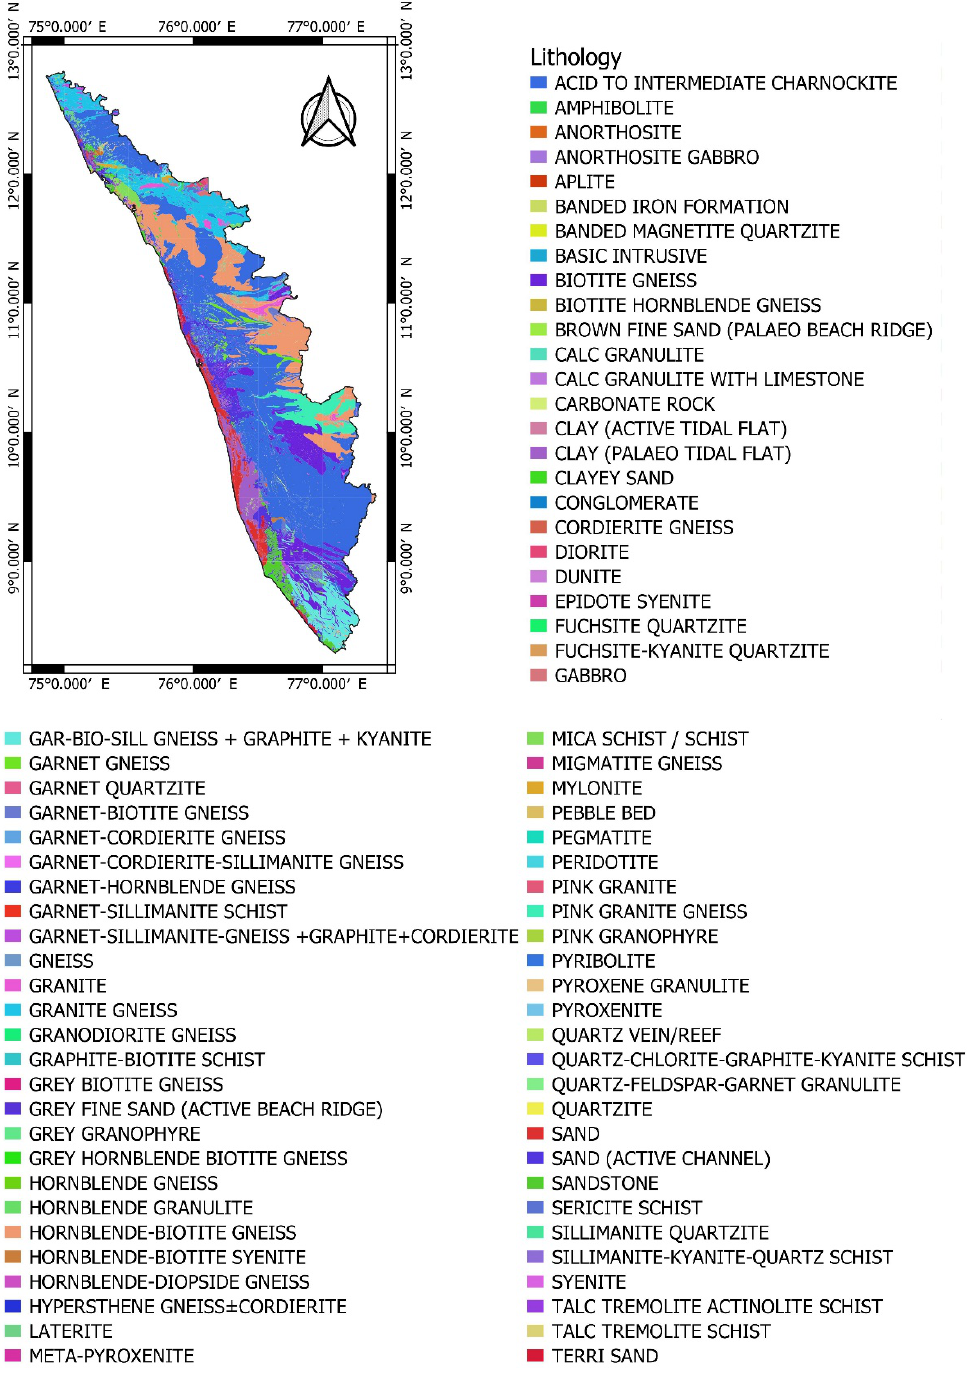
tukulam, and Kottapuram2. The district-wise distribution is four in Thiruvananthapuram; three in Ernakulam; two each in Alappuzha, Idukki, Kasaragod, and Kottayam; and one each in Kannur, Malappuram, Palakkad, and Wayanad. Out of these, 10 locations have negative groundwater level trend, while nine wells have positive groundwater level